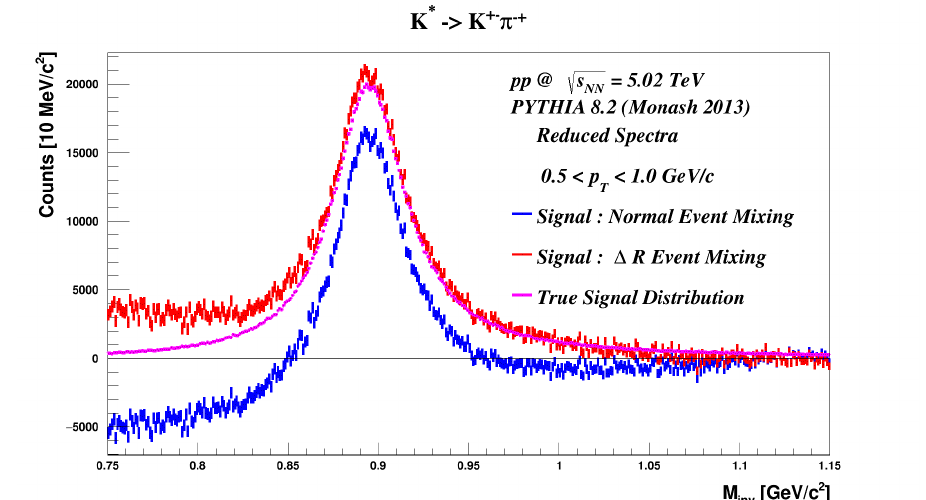
Figure 5. Signal-Background, for both reweighed and non-reweighed event-mixed distributions (the same shown in Figure